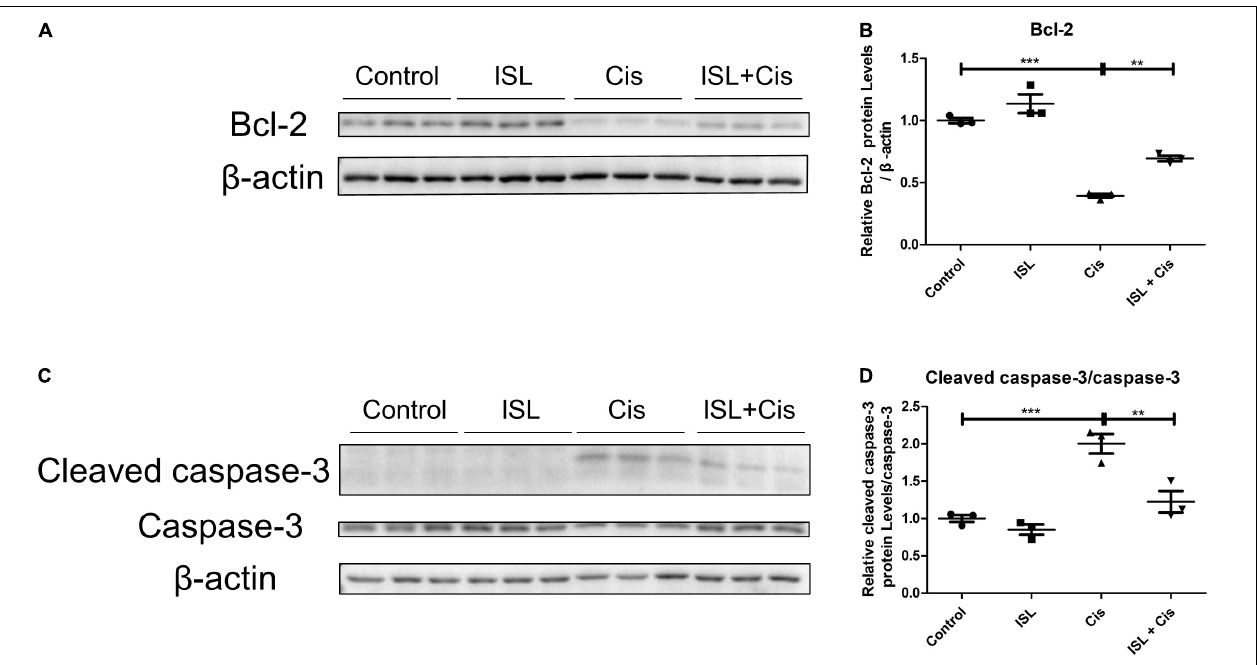
FIGURE 5 | ISL reduced the cisplatin-induced apoptosis in HK2 cells. HK2 cells were pretreated with 125 µ M ISL for 6–8 h and then incubated with 10 µ g/mL cisplatin for 24 h. (A) The expression of Bcl-2 was detected by western blotting. β -actin was used as an internal reference. (B) Densitometry analysis of the western blots of Bcl-2 ( n = 3 per group). (C) The expression of cleaved caspase-3 and caspase-3 was detected by western blotting. β -actin was used as an internal reference. (D) Densitometry analysis of cleaved caspase-3/caspase-3 ( n = 3 per group). The quantitative results are expressed as the mean ± SD of each group. ** p < 0.01, *** p < 0.001 (ANOVA with multiple